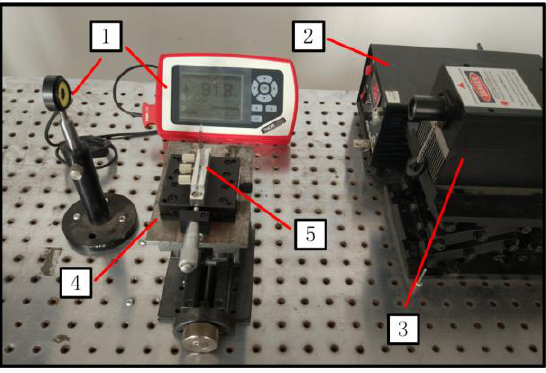
Figure 10. Laser radius measurement system. 1: photoelectric detector; 2: laser controller; 3: laser; 4: manual translation machine; 5: knife.